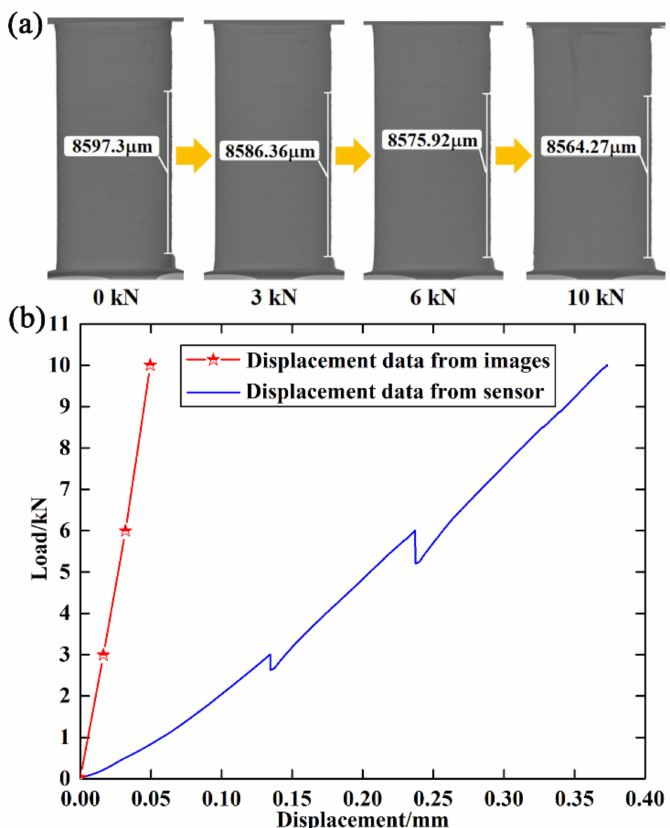
Figure 11. ( a ) Calculation of true displacement; ( b ) load–displacement curves based on the sensor and image data.